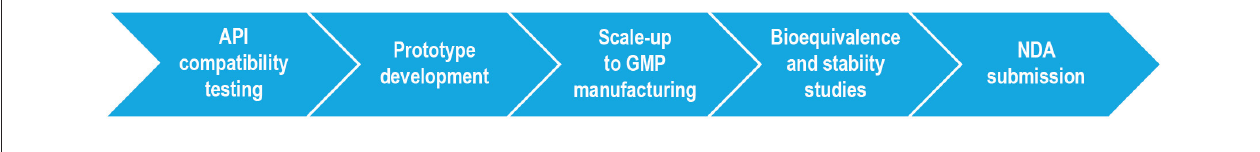
FIGURE 1 | DPP Development